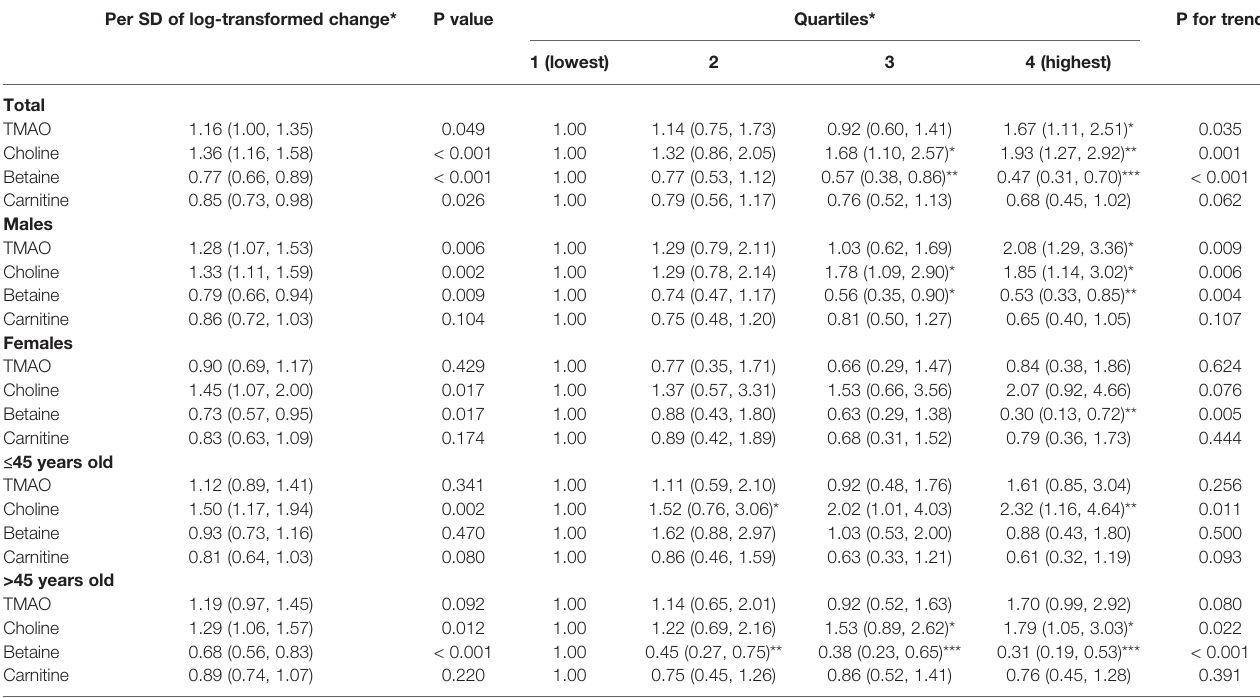
TABLE 2 | Relationship between plasma concentrations of TMAO, choline, betaine, carnitine and diabetes ( m mol/L) a . Per SD of log-transformed change* P value Quartiles*